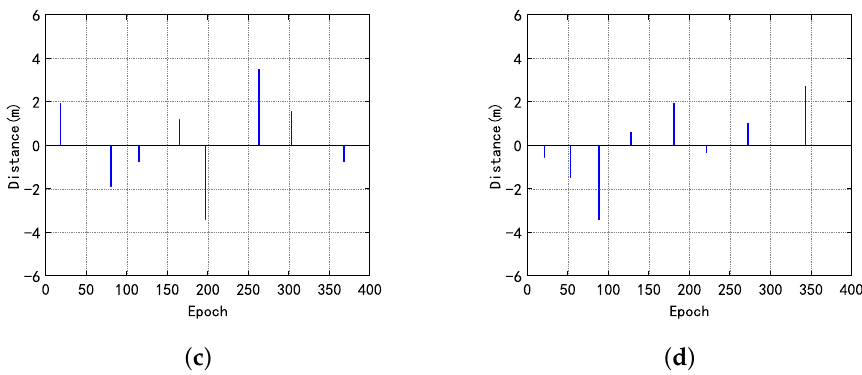
Figure 12. In the fourth case, the results at different sampling rates. ( a ) sampling period is 2 s; ( b ) sampling period is 3 s; ( c ) sampling period is 4 s; ( d ) sampling period is 5 s.